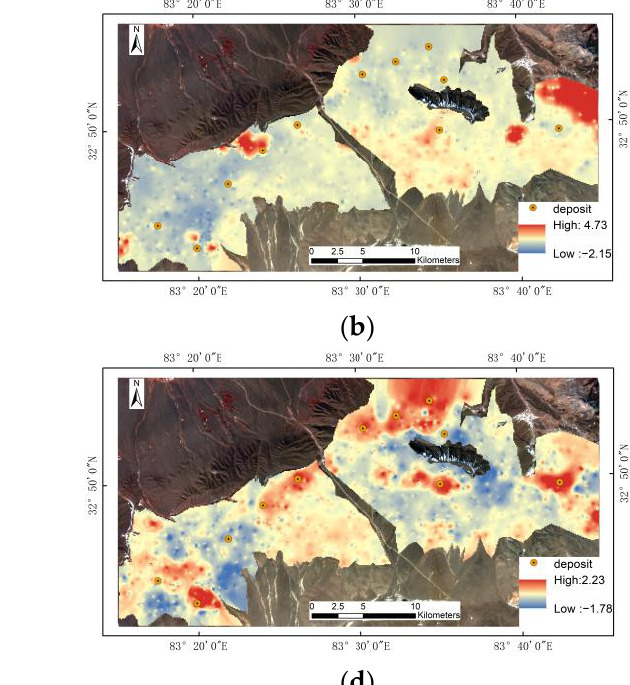
Figure 12. The first four PCs based on the geochemical dataset: ( a ) PC1; ( b ) PC2; ( c ) PC3; and ( d ) PC4.